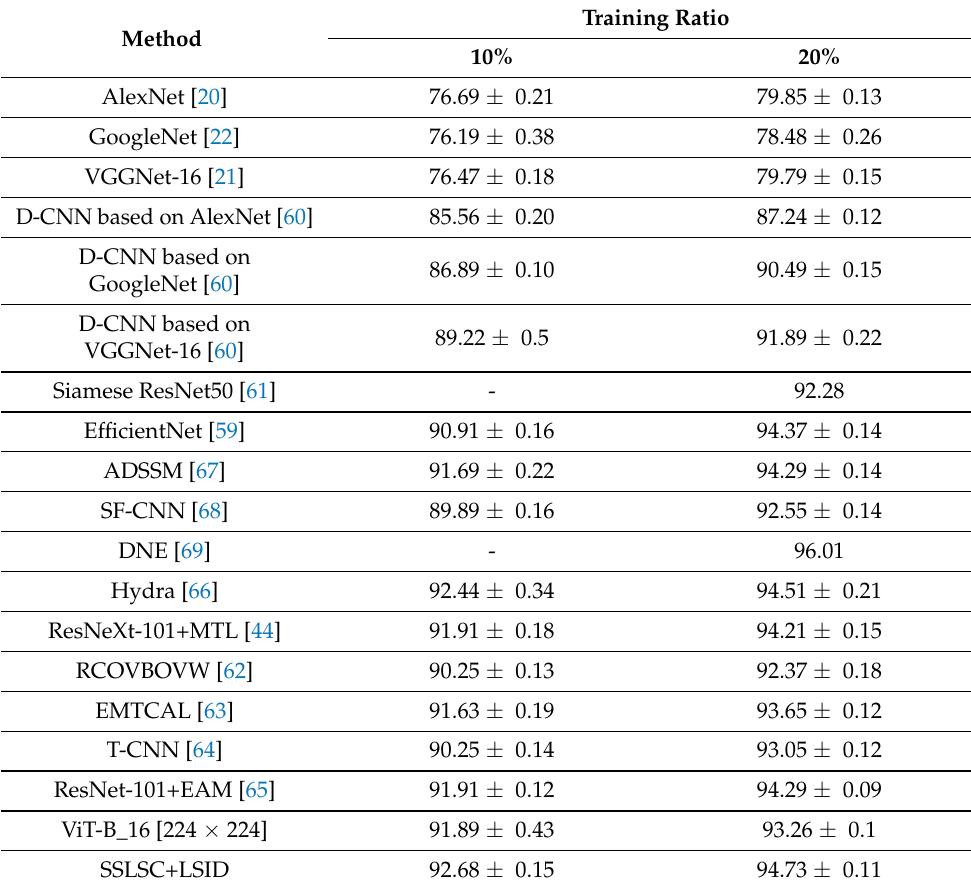
Table 2. OA (%) of eighteen kinds of methods and our method under the training ratio of 10% and 20% on NWPU